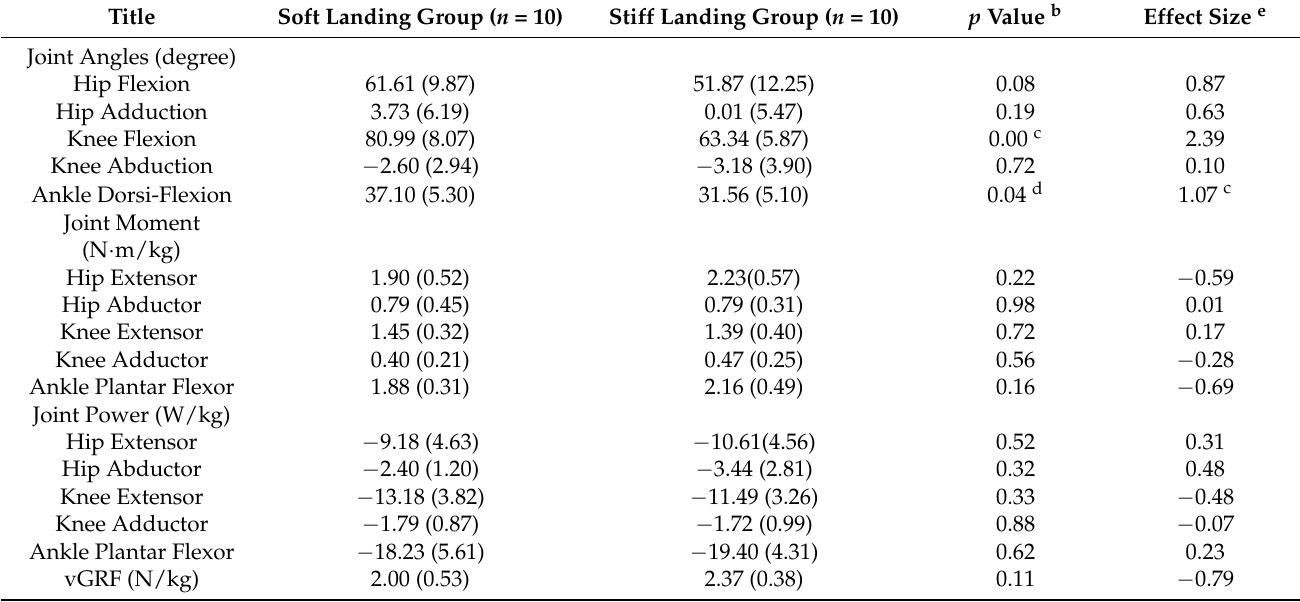
Figure 1. Joint angles, joint moments, and joint powers in the lower extremity joints in the soft and stiff landing groups. These figures represent the means and standard deviations of the hip flexion, knee flexion, and ankle dorsiflexion angles, joint moments ( b ), and powers ( c ) of the soft landing (solid lines) and stiff landing groups (broken lines) during the deceleration phase normalized to 100%. Joint moments and powers were normalized according to the participant’s body weight (kg). Table 2. The means maximum value of lower extremity joint angles, moments, powers, and vGRF during the deceleration phase of landings in the soft and stiff landing groups a